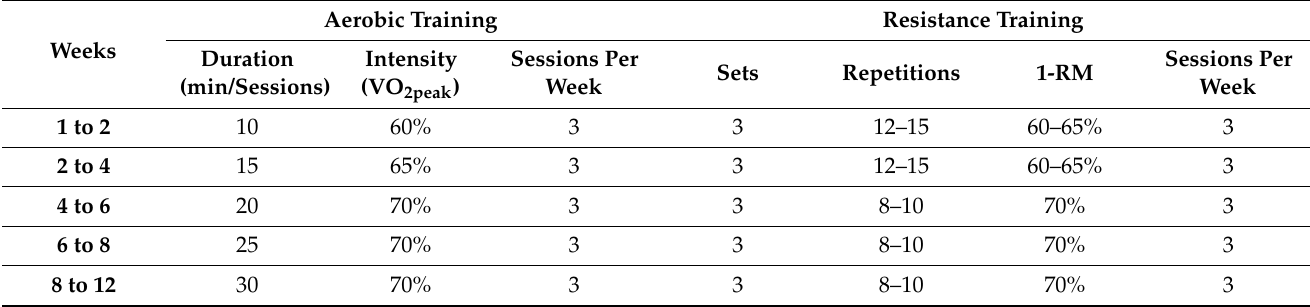
Table 1. CARET (Combine Aerobic + resistance Exercise Training) for 12 weeks.